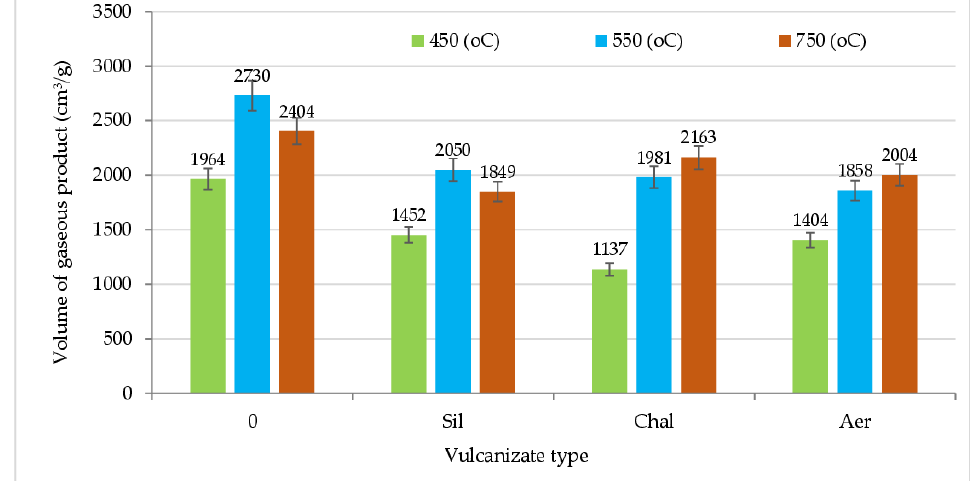
Figure 6. The volume of gaseous products formed during the combustion and decomposition of unfilled and filled vulcanizates at the temperatures of 450, 550 and 750 °C. The basis for the classification of thermal decomposition and combustion products is the parameter W LC50SM . According to PN-B-02855:1988, the products should be considered very toxic if W LC50SM ≤ 15, the products are toxic if 15 ≤ W LC50SM ≤ 40 and the products are moderately toxic if W LC50SM > 40. The WLC 50SM values show that gaseous products gener-